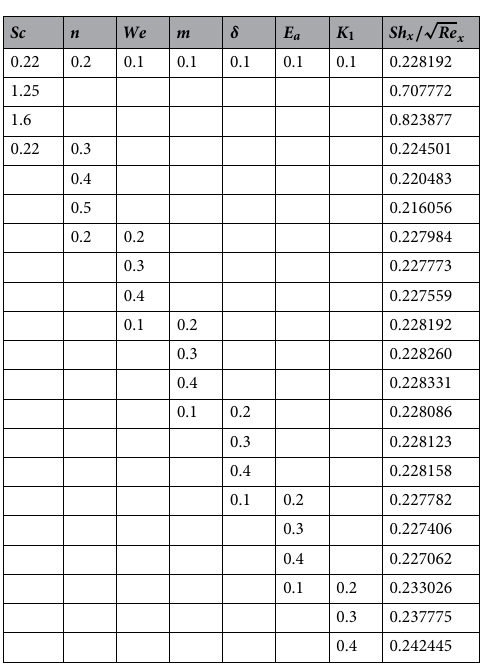
Table 4. Variation of Sh x / √ Re x when